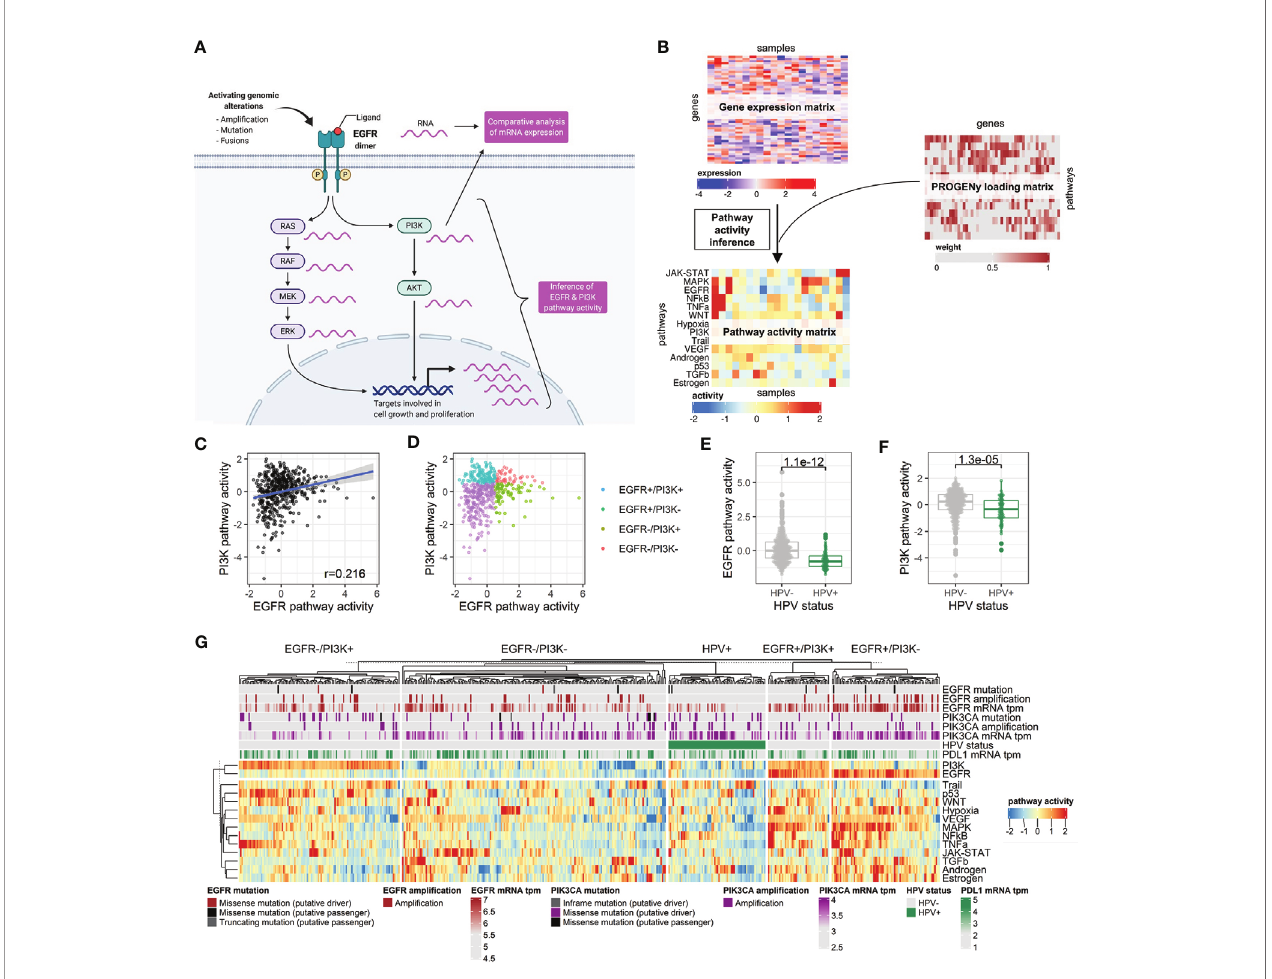
FIGURE 1 | Pathway activity inference in head and neck cancer tissues. (A) Graphical abstract of the approach. In contrast to differential mRNA expression analysis of genes of interest (e.g., EGFR and PI3KCA), pathway activity can be statistically inferred by integrating expression values of all genes known to be perturbed upon pathway alteration. Adapted from “ HER2 Signaling Pathway ” , by BioRender.com (2020). Retrieved from https://app.biorender.com/biorender-templates. (B) The PROGENy algorithm is used to infer the activity of 14 key pathways involved in oncogenesis. Activities are calculated by matrix multiplication of the normalized gene expression matrix and the so-called PROGENy loading matrix that contains the full human pathway model of 22,479 genes with associated pathways, weights, and p-values (22). (C) Correlation between EGFR and PI3K pathway activity across the cohort. (D) Pathway activity-based grouping of HNSCC tumors. (E) EGFR and (F) PI3K pathway activity strati fi ed by HPV status. (G) Heatmap of pathway activity matrix of the TCGA-HNSC cohort (n = 498). The column annotation contains genetic alterations and normalized mRNA expression values of genes of interest, as well as the HPV